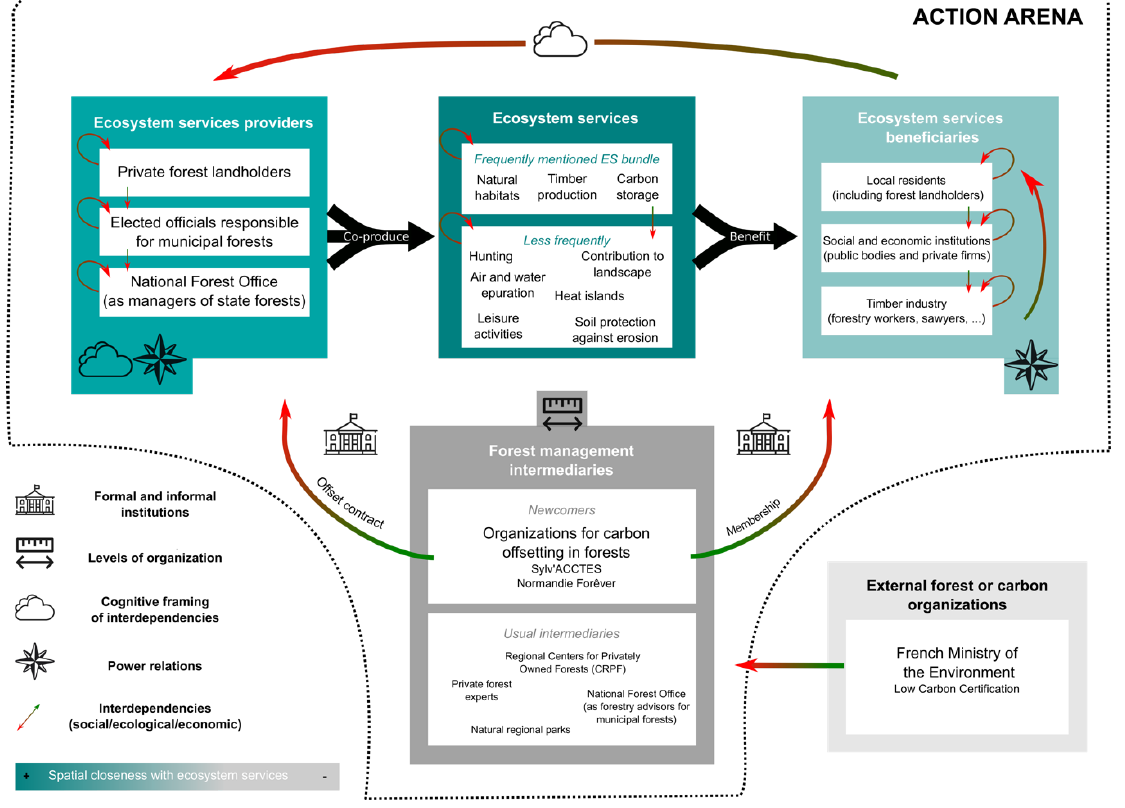
Figure 2. The conceptual framework for ecosystem services (ES), social interdependencies, and collective actions applied to French forest socio-ecosystems.